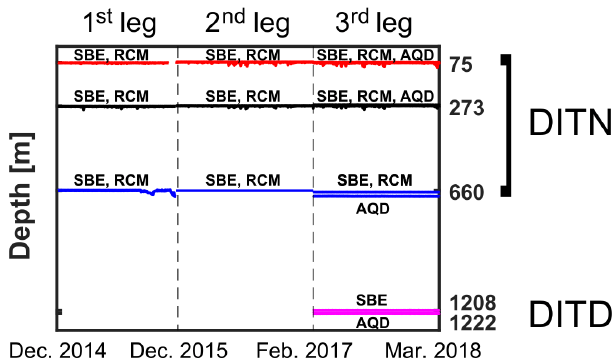
Figure 2. The recorded sensor depths during the three observation legs. The red, black, and blue lines show the depth time series for sensors at the upper, middle, and deep layer of the DITN. A magenta line also shows the recorded sensor depths of the DITD. The SBE, RCM, and AQD represent the SBE37SM, RCM9, and Aquadopp current meters, respectively (see details in Table